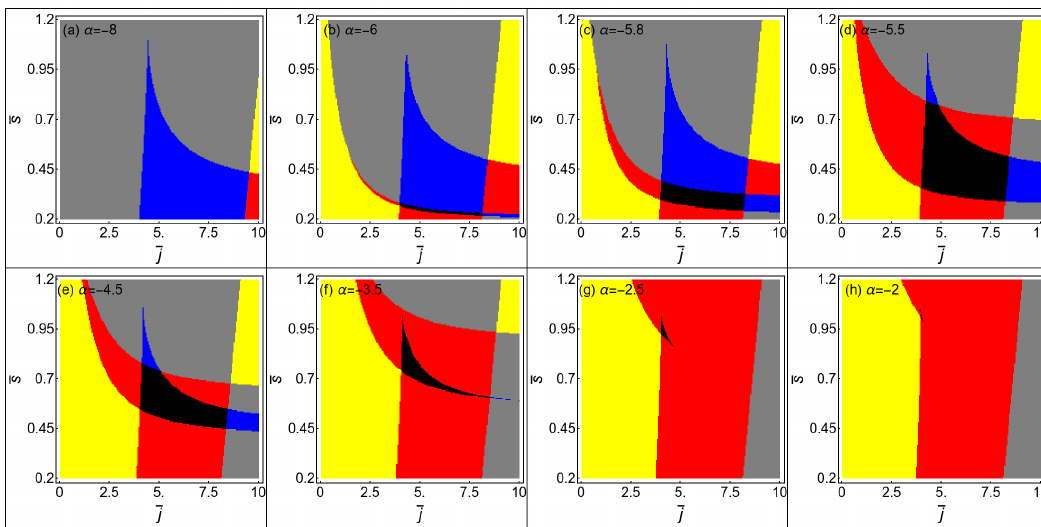
Figure 3. Plots of the parameter space ( ¯ s − ¯ j ) describing whether a spinning test particle have two stable circular orbits with the same spin ¯ s and the same total angular momentum ¯ j . The parameters are set as M = 1 and m = 1. In the black and blue regions, the effective potential has two minima corresponds two stable circular orbits. In the red region the effective potential has one minimum and the test particle has one stable circular orbit. In the gray and yellow regions, the test particle has no stable circular